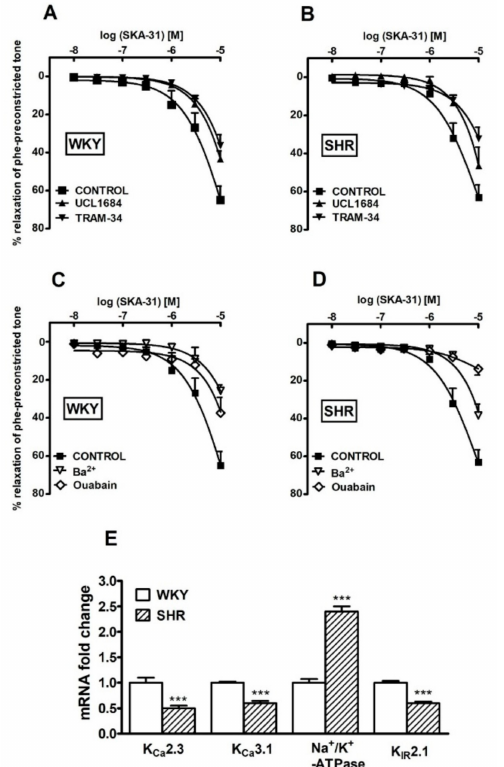
Figure 6. Influence of UCL1684 (0.1 µ M), TRAM-34 (10 µ M), Ba 2 + (30 µ M) and ouabain (100 µ M) on the vasorelaxant e ff ect of SKA-31 in the presence of l -NAME and indomethacin (INDO) (100 µ M and 10 µ M, respectively; CONTROL) in small mesenteric arteries from normotensive Wistar Kyoto (WKY) ( A , C ) and spontaneously hypertensive (SHR) rats ( B , D ). RT-qPCR analysis of K Ca 2.3 , K Ca 3.1 , Na + / K + -ATP-ase , and K ir 2.1 in vessels isolated from SHR and WKY rats. Results shown as relative fold change in mRNA expression in SHR in comparison to WKY controls, where expression level was set as 1.0 ( E ). Results are expressed as a percentage of relaxation of the isometric contraction induced by phenylephrine (Phe). Mean ± SEM of n = 5–14 animals for each curve. In a few cases, the SEM is smaller than or equal to the size of symbols. *** p < 0.001 compared to WKY. See Table 2 for statistical